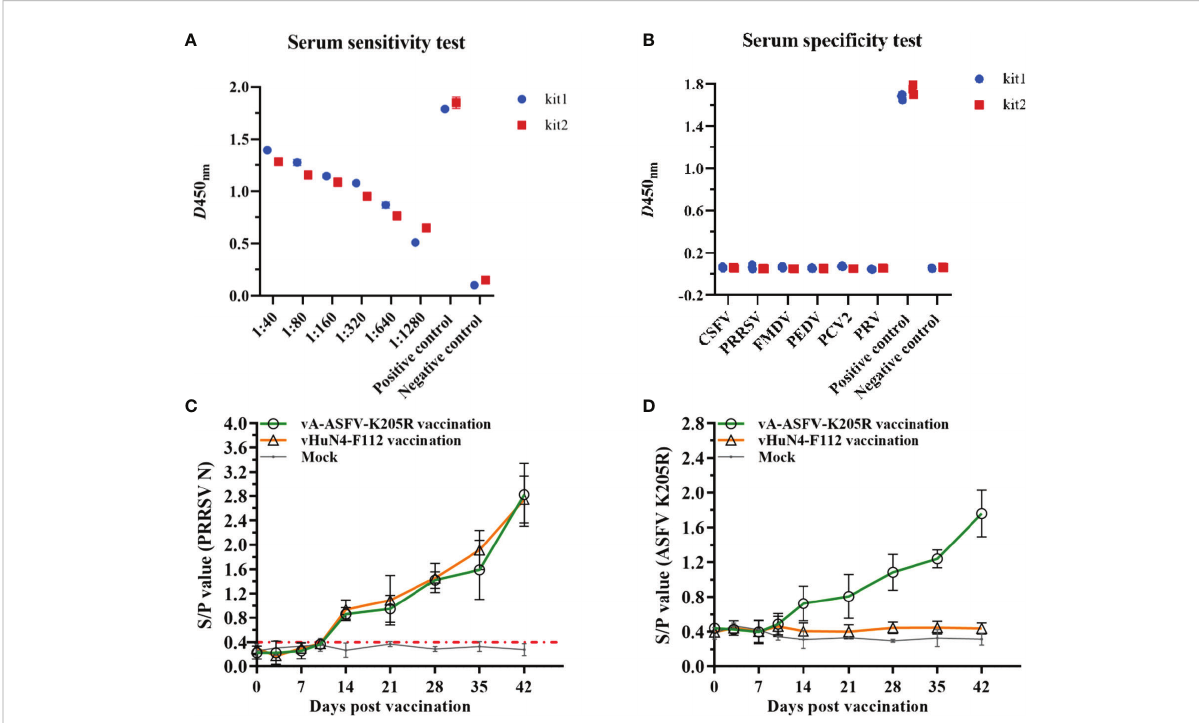
FIGURE 7 The indirect ELISA method against pK205R ef fi ciently detected clinical samples and recombinant PRRSV virus expressing ASFV antigen. (A) Sensitivity testing of the ELISA method and the commercial ELISA kit using positive sera of ASFV. (B) Speci fi city testing of the method using CSFV, PRV, PRRSV, PEDV, FMDV, PCV2 and ASFV sera samples. (C) The PRRSV-speci fi c humoral immune response was assessed by the S/P value identi fi ed from serum samples collected at the indicated time points from piglets in vA-ASFV-K205R, vHuN4-F112, and mock groups. (D) pK205R-speci fi c serum antibodies of the three groups were tested using the indirect ELISA method.